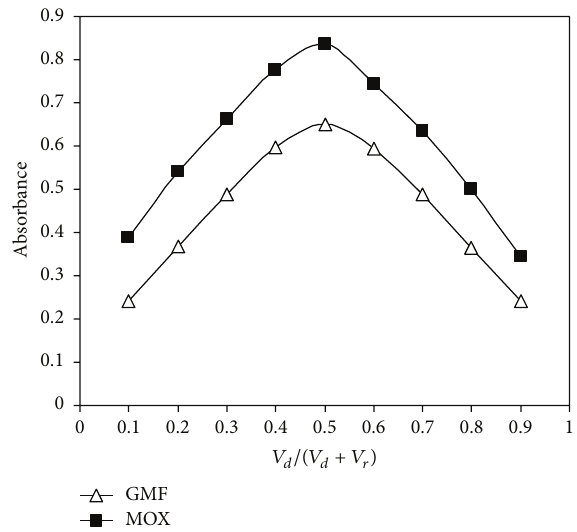
Figure 9: Job’s method of continuous variations; [D] + [NBD-Cl] = 5.0 × 10 −4